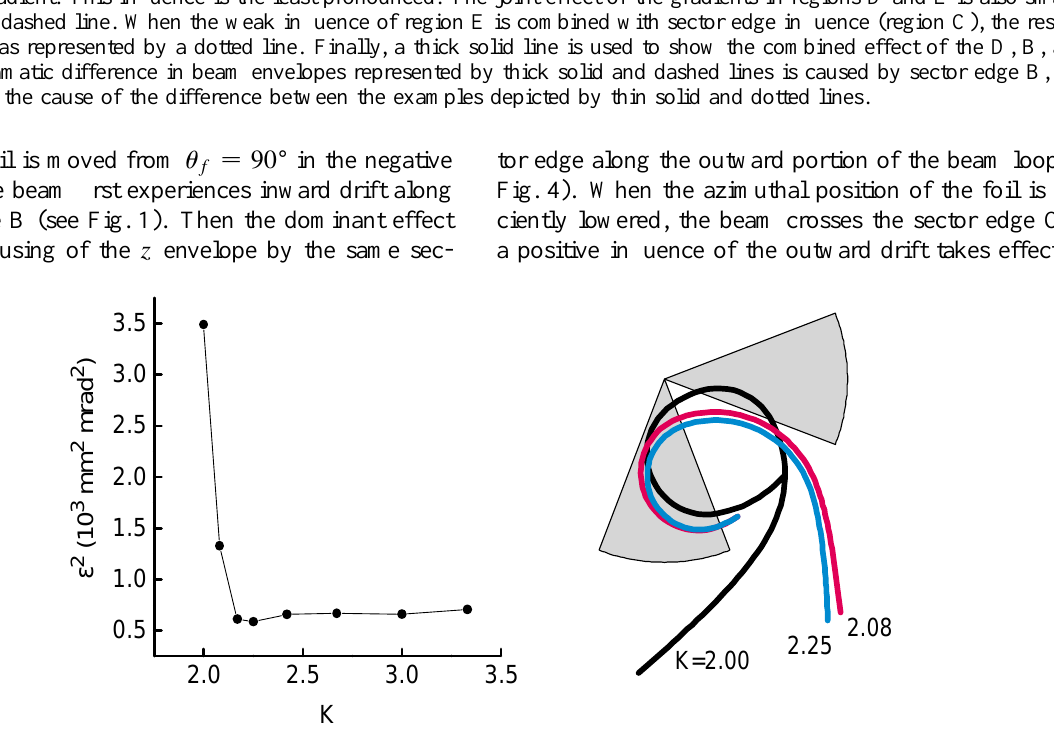
FIG. 6. (Color) Dependence of minimum square emittance on the K parameter. Behavior of the beams with initial emittances and energy spread as in Fig. 4, and with foil positions along the equilibrium orbit, is simulated. Beams with minimum square emittances at the exit from the cyclotron are represented as points on the left graph. Minimum square emittances for K $ 2.17 do not depend much on K and are of the order of 600 mm 2 mrad 2 . Central trajectories of beams with minimum square emittance shown in the right-hand plot justify larger values of the square emittance for K (cid:1) 2 and 2.08. For K (cid:1) 2.08 , the beam passes close enough to the sector edges both on the inward and outward portion of the loop to experience defocusing. For K (cid:1) 2 , the radius of the loop is so large that, in addition to defocusing, a small inward drift is